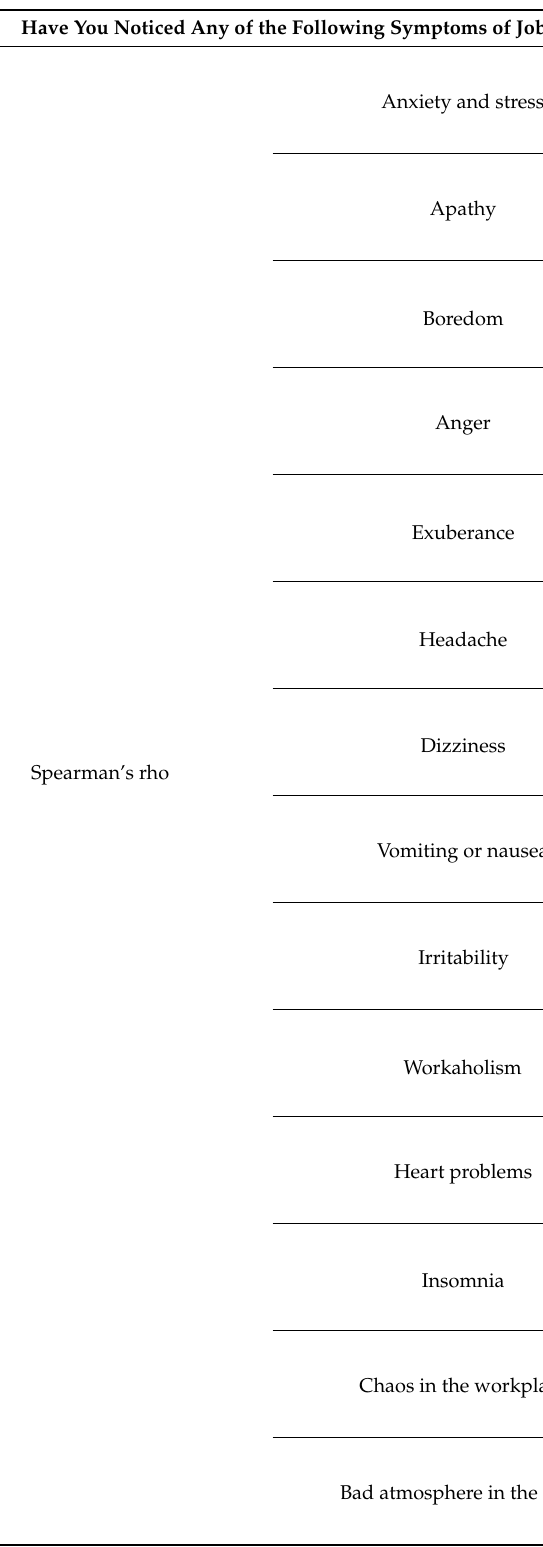
Table 7. Prevalence of burnout symptoms vs. age of